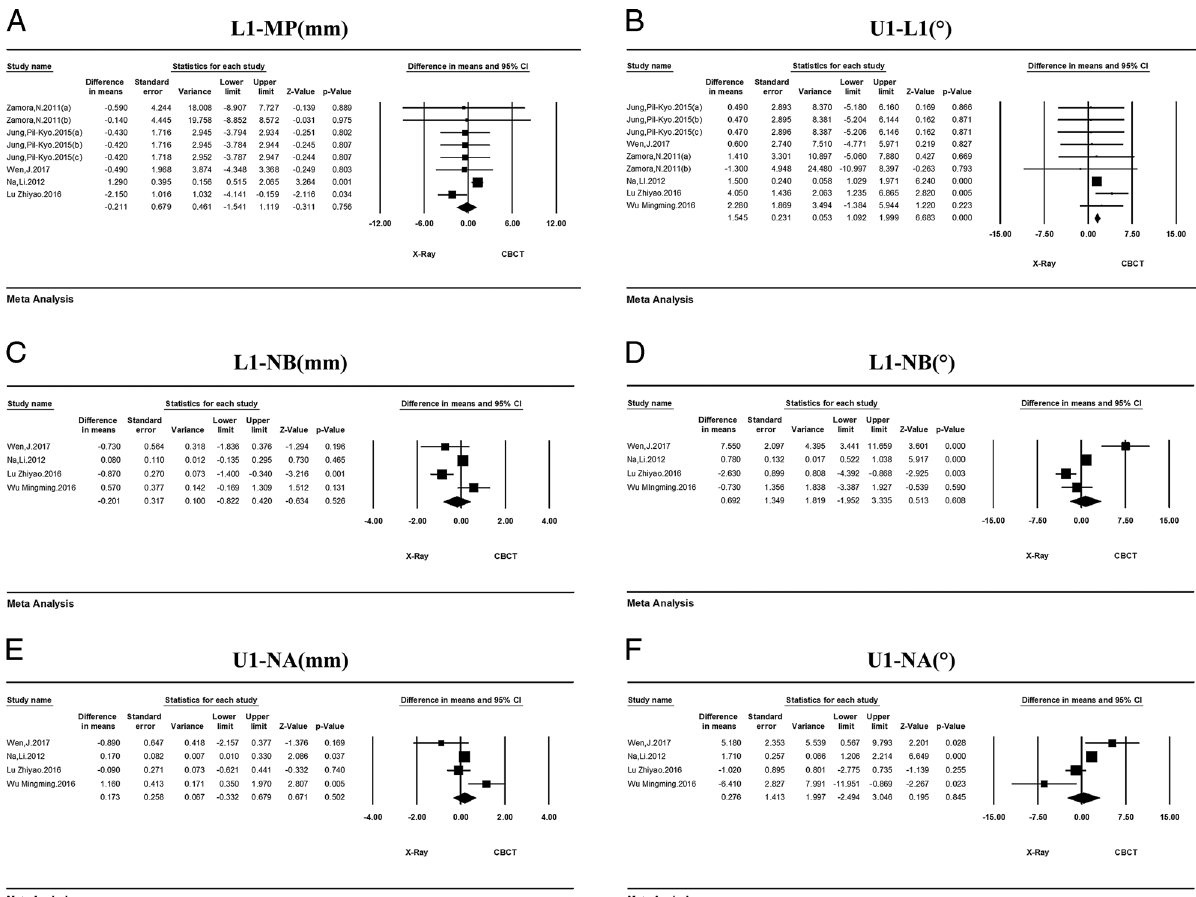
Figure 4. Forest plots of pooled DM for the CBCT group versus the X-ray group (A) L1-MP, (B) U1-L1(°), (C) L1-NB(mm), (D) L1-NB (°), (E) U1-NA(mm), (F)